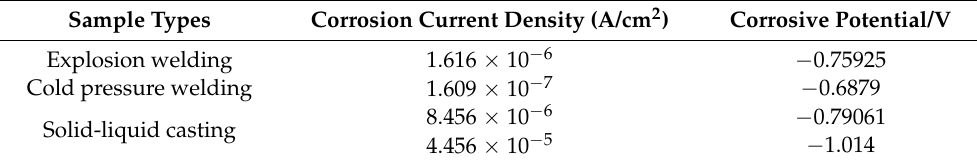
Table 3. The corrosion potential and the corrosion current density in Figure